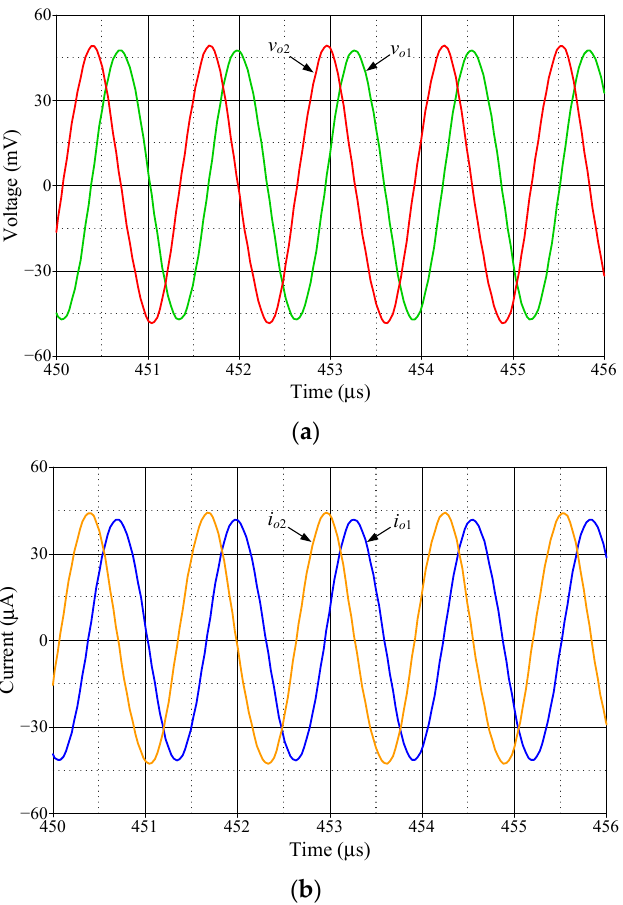
Figure 22. Simulated output waveforms for the DM-QO in Figure 21: ( a ) v o 1 and v o 2 ; ( b ) i o 1 and i o 2 .